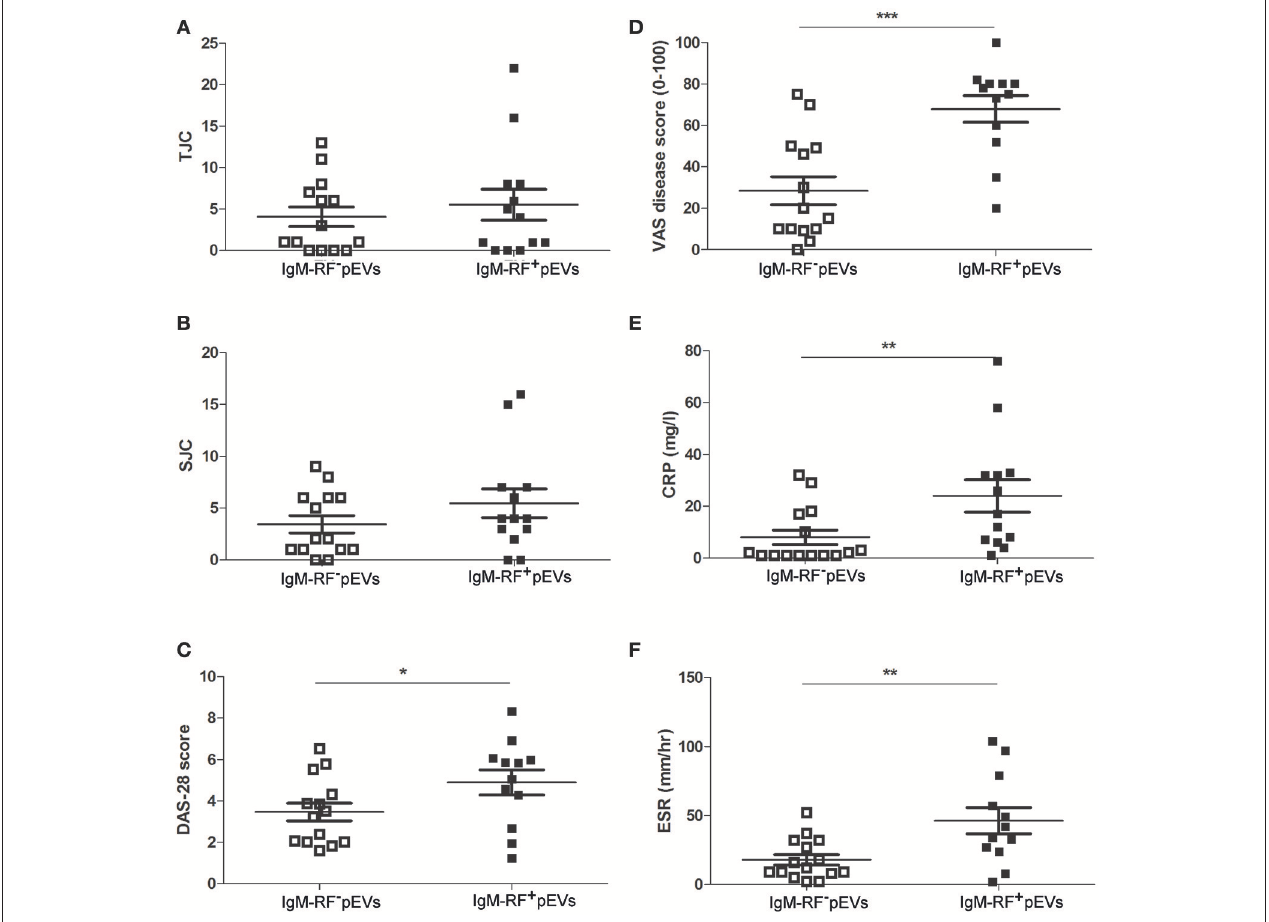
FIGURE 6 | Clinical parameters related to IgM-RF containing pEVs . Clinical parameters were obtained at time of blood donation. RF + RA patients were dived in 2 subgroups based on the presence of IgM-RF + pEVs and IgM-RF − pEVs in their circulation. TJC (A) , SJC (B) , DAS28 (C) , VAS disease activity (D) , CRP and ESR levels (E,F) of these 2 subgroups are shown. Statistically significant differences were determined by Mann-Whitney test, * p < 0.05, ** p < 0.01 and *** p <